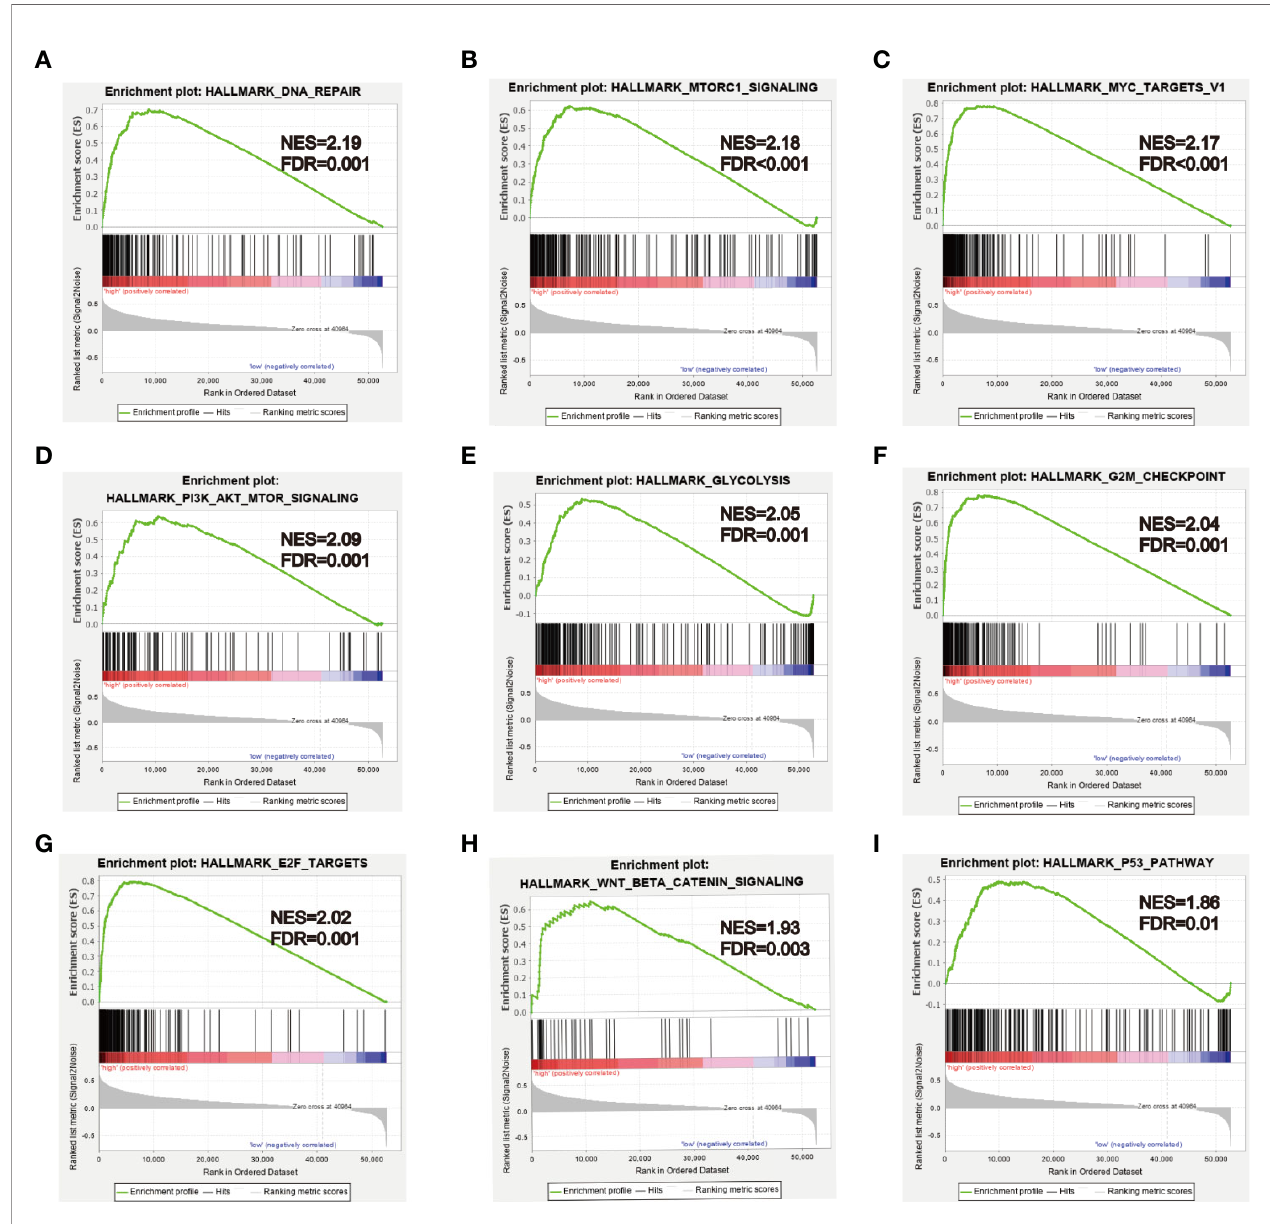
FIGURE 11 | GSEA analysis between high- and low-risk groups. (A – I) Some cancer-related pathways were gathered in high-risk group: “ DNA REPAIR, ” “ MTORC1_SIGNALING, ” “ MYC_TARGETS_V1, ” “ PI3K_AKT_MTOR SIGNALING, ” “ GLYCOLYSIS, ” “ G2M_CHECKPOINT, ” “ E2F_TARGETS, ” “ WNT_BETA_CATENIN_SIGNALING, ” “ P53_PATHWAY. ” NES, Normalized enrichment